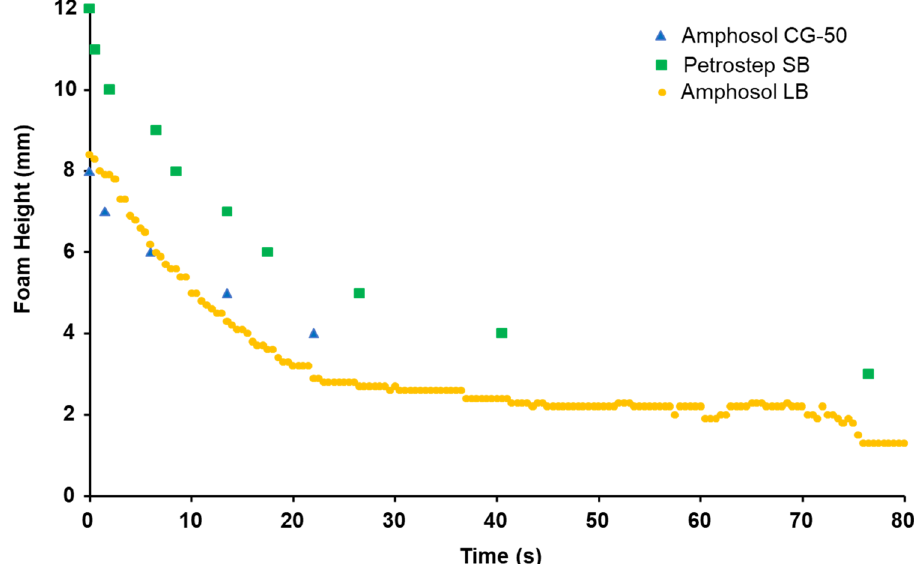
Figure 11. Bulk foam height and stability measurements performed using Krüss High Pressure Foam Analyzer instrument for